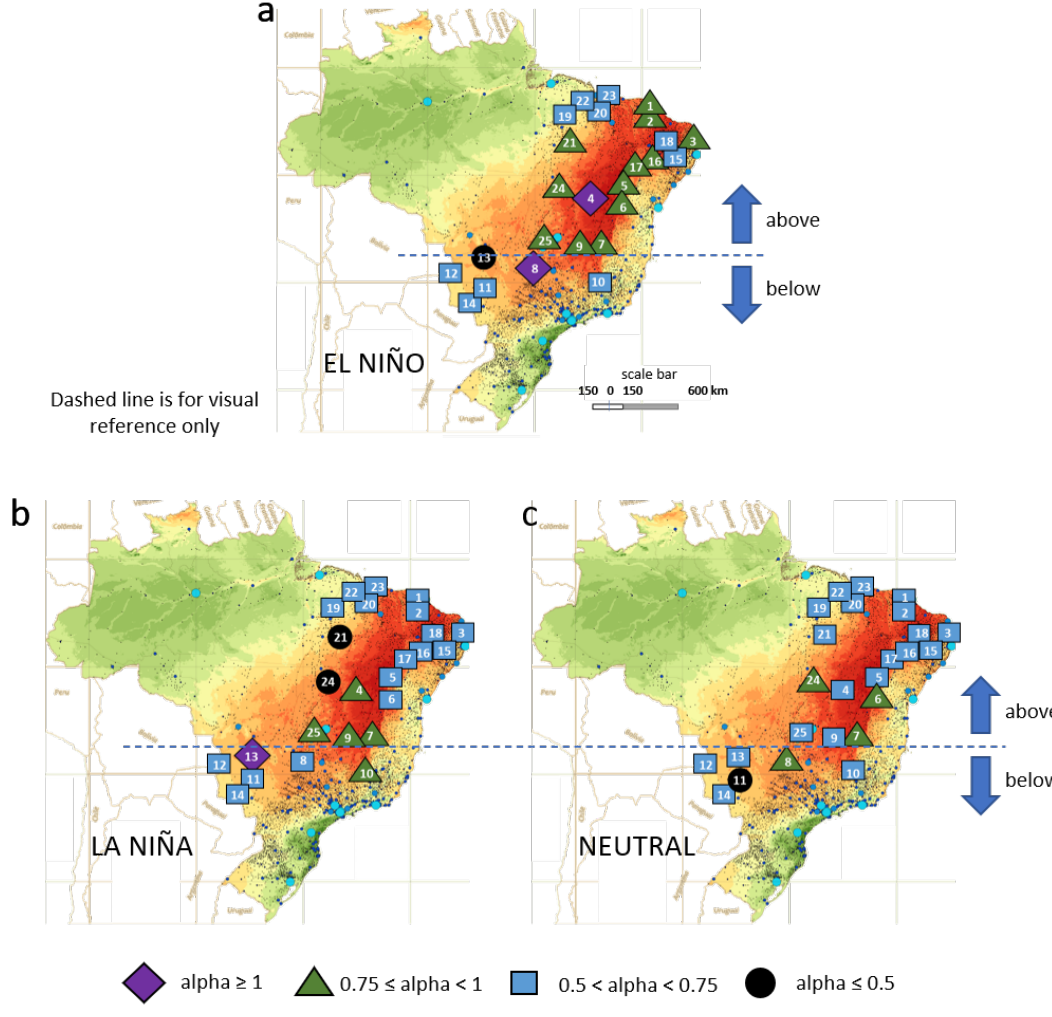
Figure 9. Spatial evaluation of α values for the El Niño ( a ), La Niña ( b ), and Neutral ( c ) periods in Brazil. The maps were divided by Above the Dashed Line (ADL) and a Below the Dashed Line (BDL) regions, only for visual purposes. Most alpha values changed from a lower range to a higher range of persistence ADL during El